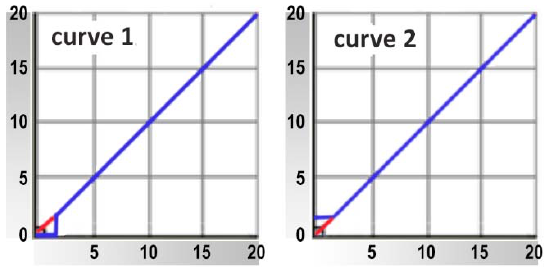
Figure 10. Variations in the application of “bump-up” curves in prepress for printing.